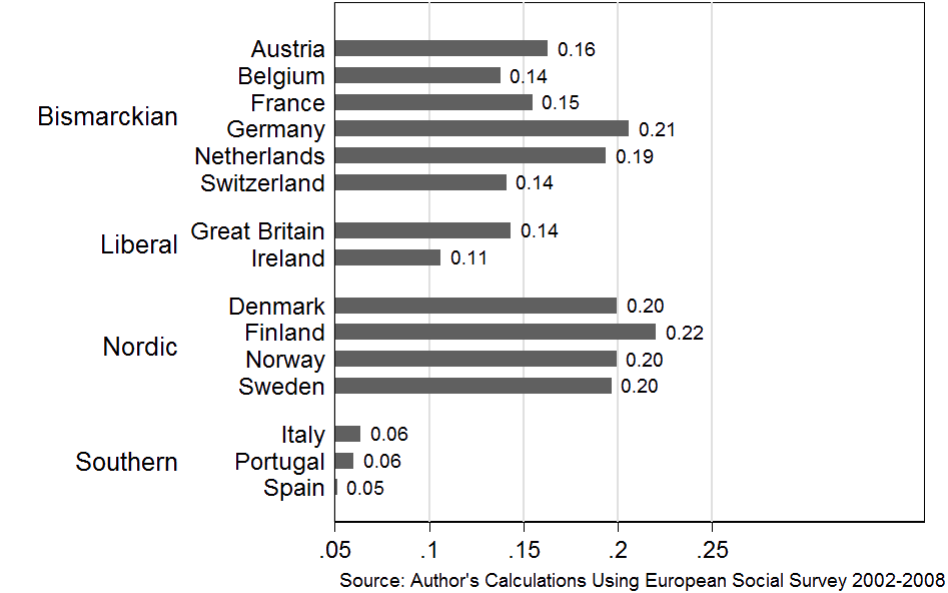
Figure 3: Proportion of Working Age Adults with Tertiary Degree Reporting Disability Nordic European countries have significantly higher odds of reporting a